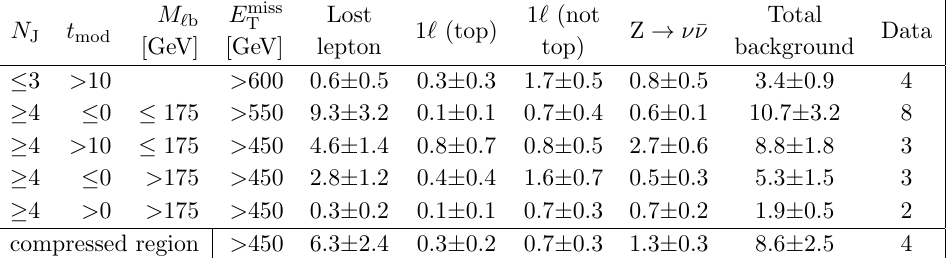
Table 7 . Background predictions and yields in data corresponding to 35.9 fb (cid:0) 1 for aggregate signal